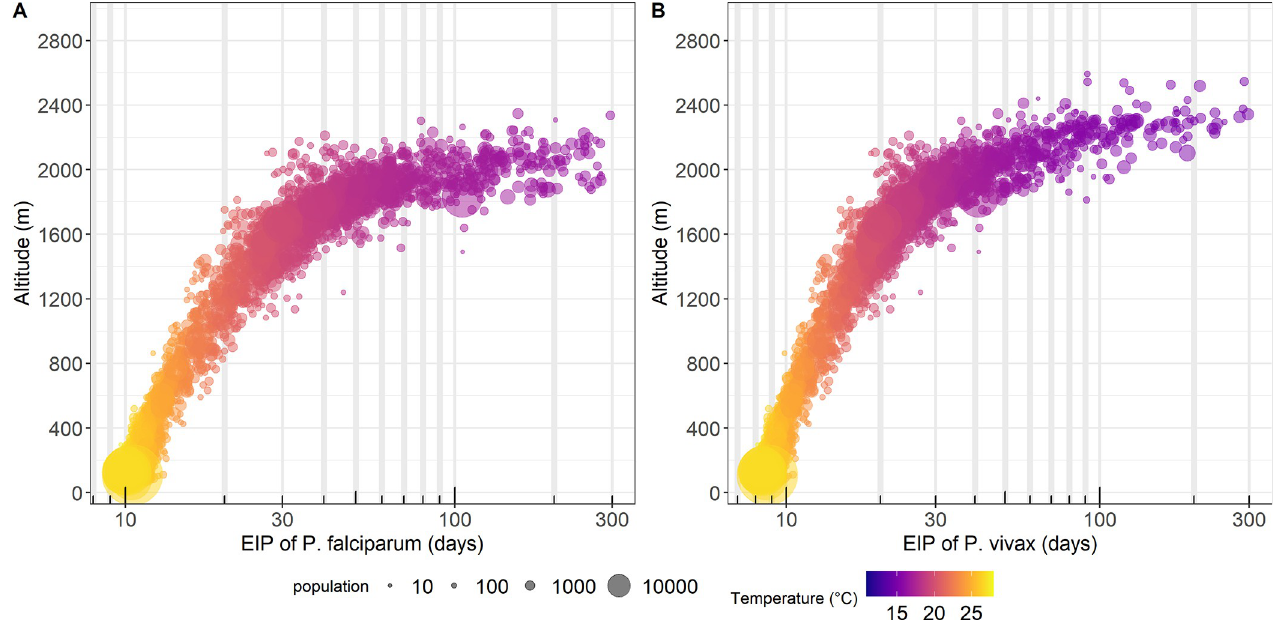
Fig 1. The relationship between altitude and temperature suitability for malaria in PNG. The dots represent duration of extrinsic incubation period (EIP) at the level of census wards of PNG: A) EIP for P . falciparum , and B) EIP for P . vivax .